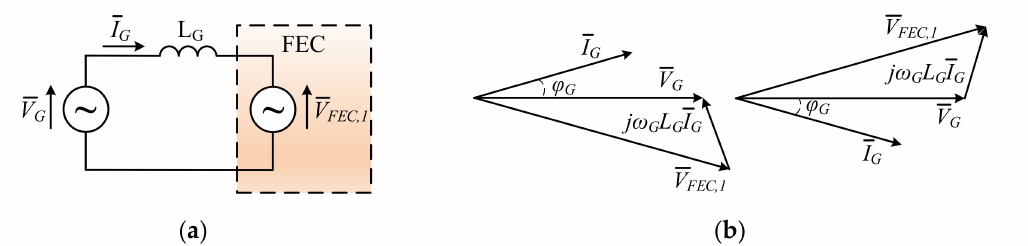
Figure 5. ( a ) Equivalent circuit of the FEC input and ( b ) related phasor diagram for maximum V FEC,1 during charging and discharging mode, respectively.